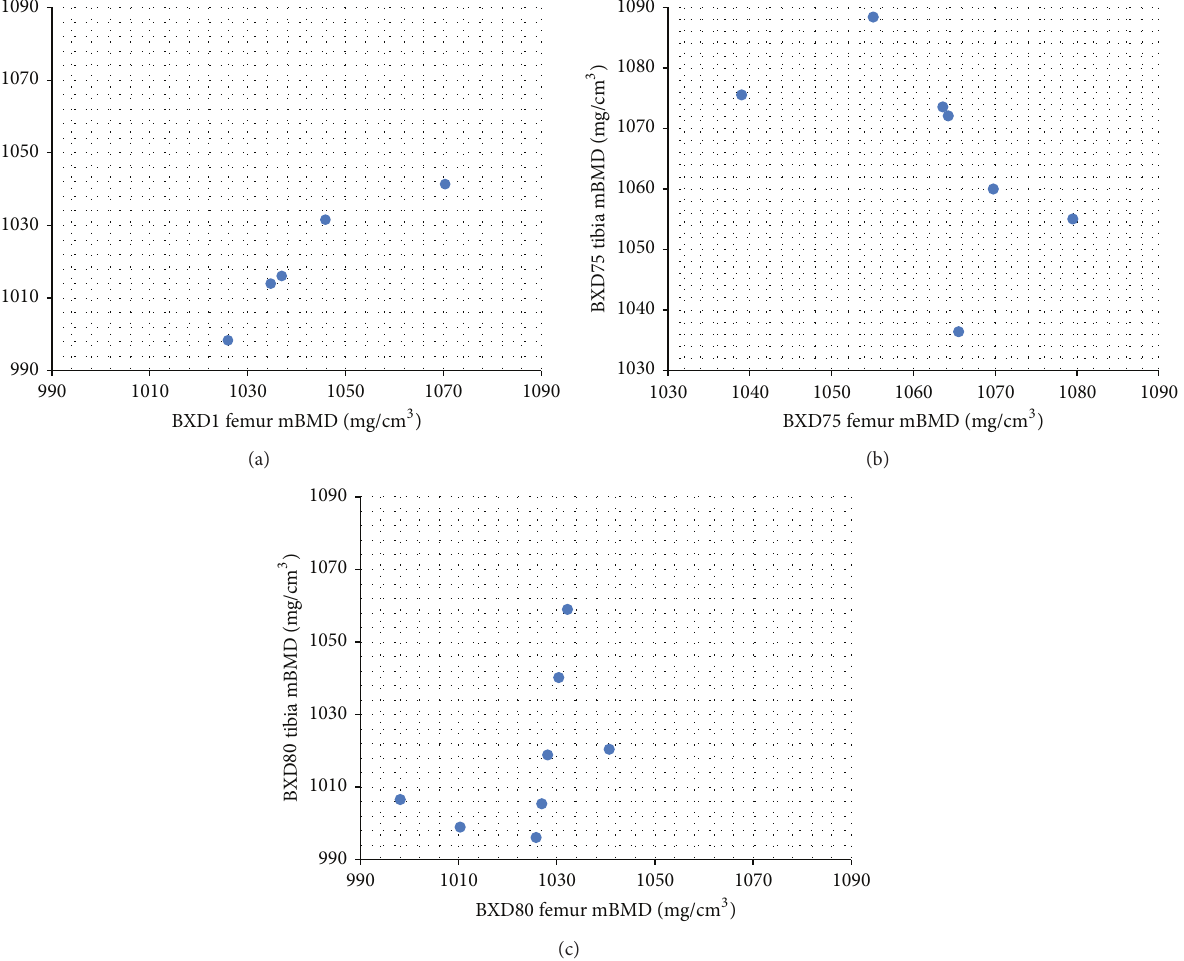
Figure 2: Spearman’s rank correlations in mBMD differed between strains. (a) RI Strain BXD1 ( 𝑟 = 1.0 , 𝑃 < 0.0001 ); (b) RI Strain BXD75 ( 𝑟 = −0.86 , 𝑃 = 0.01 ); (c) RI Strain BXD80 ( 𝑟 = 0.9 , 𝑃 = 0.04